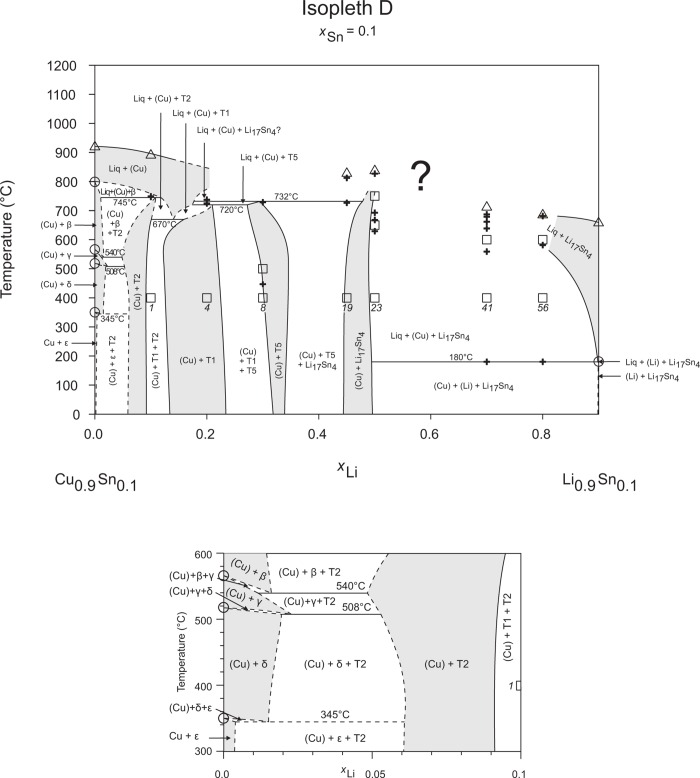
Isopleth D including section from xLi = 0–0.10 / T = 300–600°C.